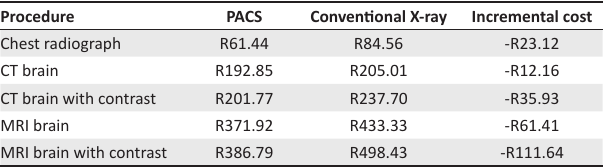
TABLE 6: Overall incremental imaging cost of PACS v. conventional X-ray (net present value).